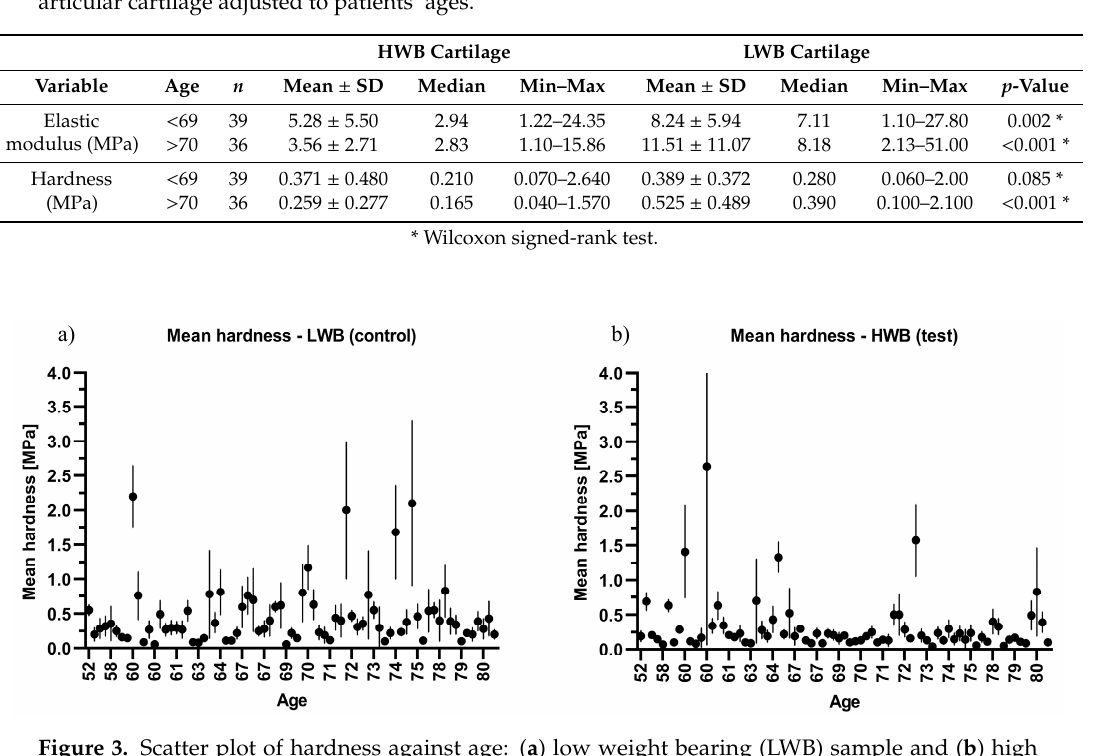
Table 4. Elastic modulus and hardness of high weight bearing (HWB) and low weight bearing (LWB) articular cartilage adjusted to patients’ ages.